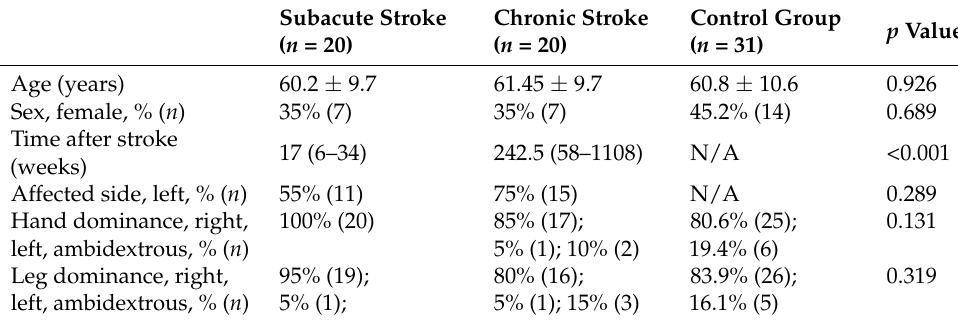
Table 1. Baseline clinical and demographic features of participants.